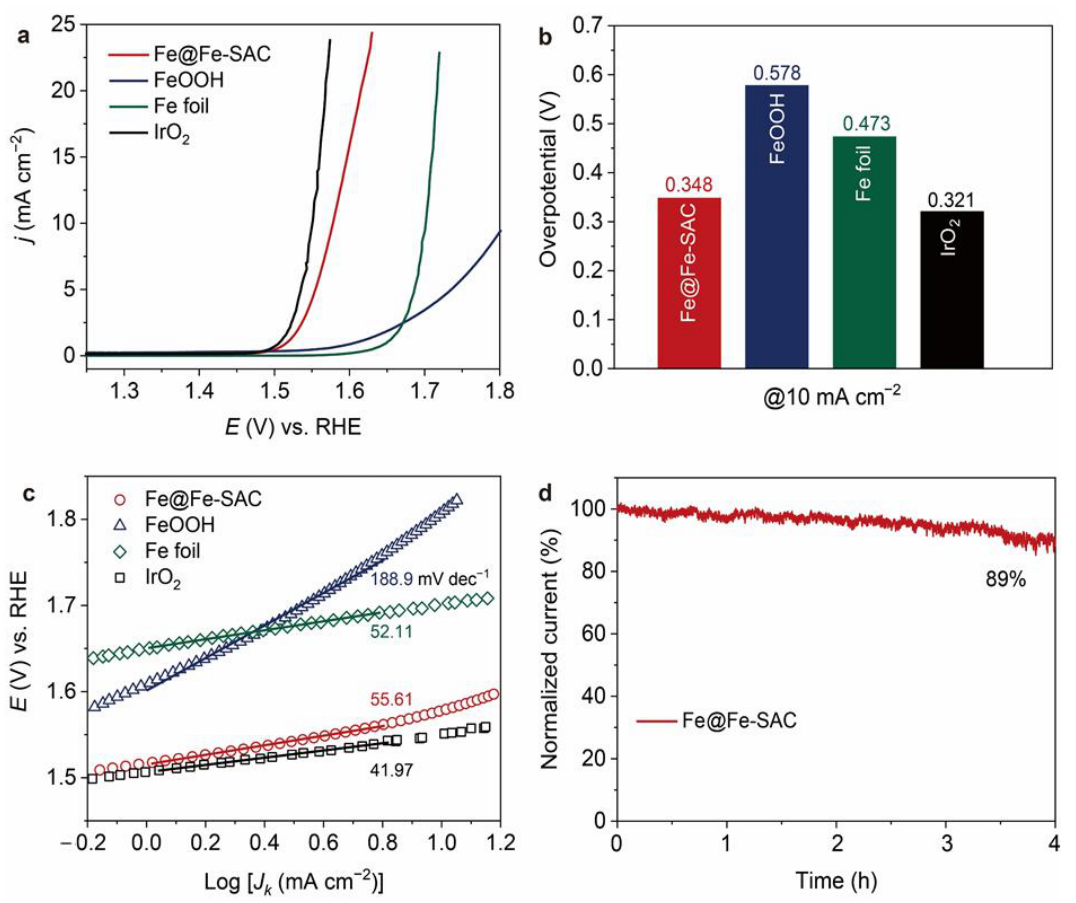
Figure 6. Electrocatalytic OER performance of Fe@Fe-SAC. ( a ) OER polarization curves recorded in an O 2 -saturated 1 M KOH solution. ( b ) Overpotentials at a current density of 10 mA cm − 2 . ( c ) Tafel plots derived from OER polarization curves. ( d ) Chronoamperometric responses of Fe@Fe-SAC at 1.6 V in 1 M KOH solution.